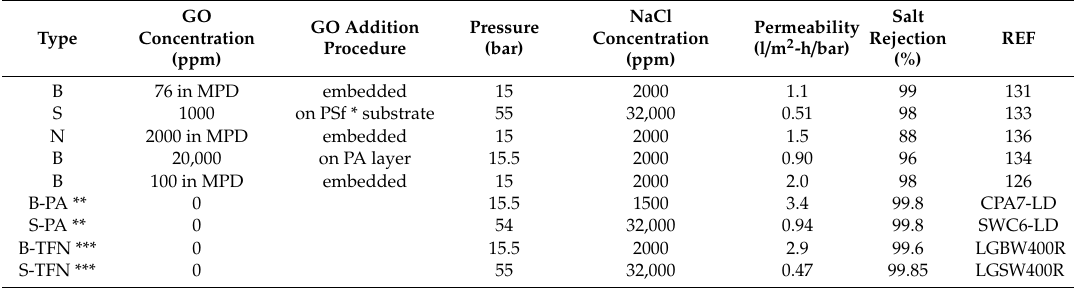
Table 13. Performance of various polyamide (m-phenylenediamine (MPD)–trimesoyl chloride) composite membranes prepared with graphene oxide (GO) as compared to commercially available, polyamide (PA), and thin-film nanotechnology (TFN) membranes. Type: B = brackish water, S = seawater, N = nanofiltration. Adapted from Ali et al. [287]. Used with permission of Elsevier B.V.